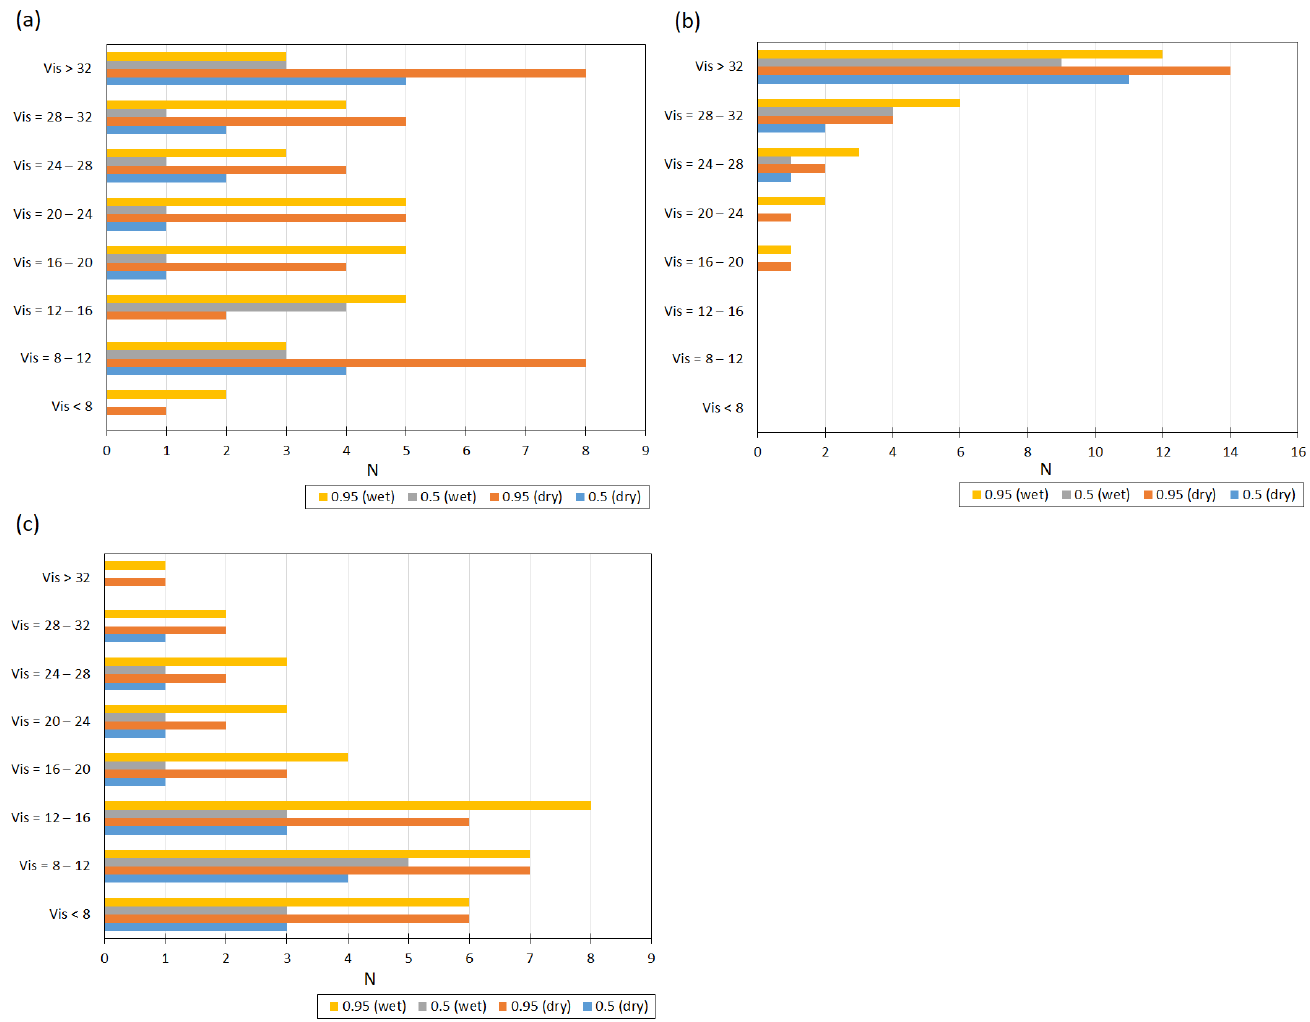
Figure 5. Number of days (N) over a two-week period in the variability range Vis = 8–32 km for dry and wet weather for the period: ( a ) spring; ( b ) summer; ( c ) winter.